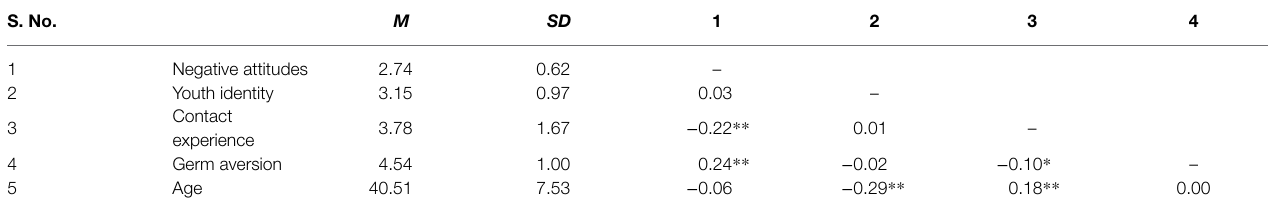
TABLE 1 | Means, standard deviations, and correlation coefficients by variable. S. No.